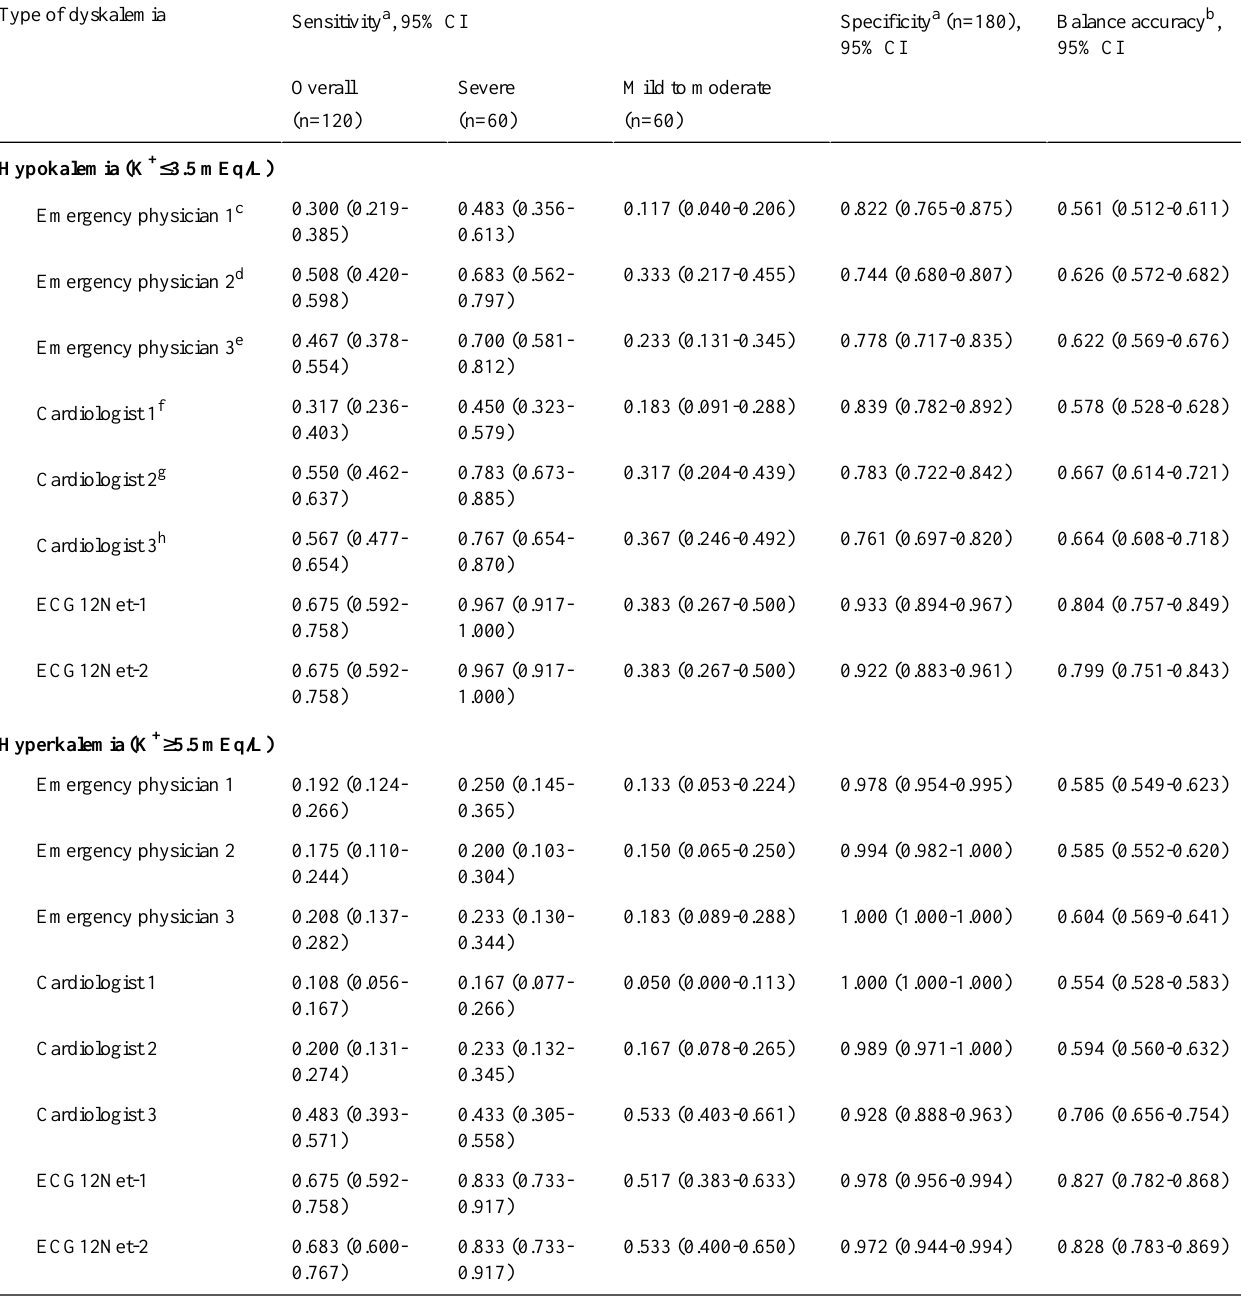
Table 2. Comparison between human experts and ECG12Net on the sensitivity and specificity in the subtest set